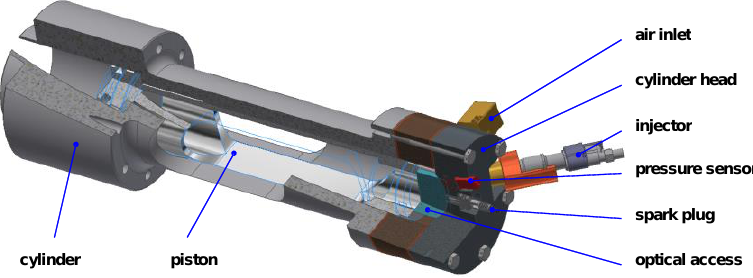
Figure 6. View of the optical stand for the analyses.